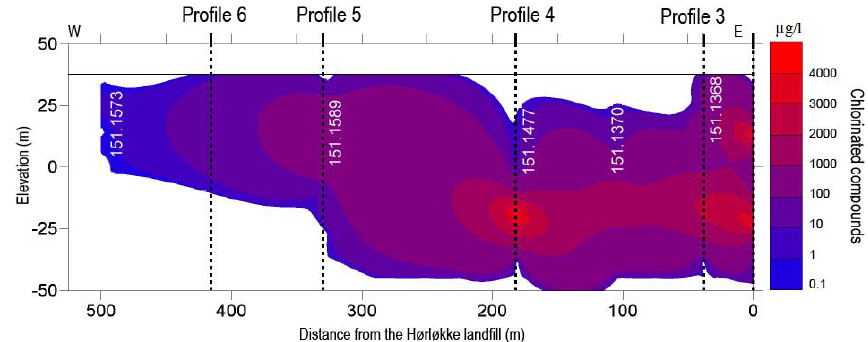
Fig. 2. Cross-section of the contaminated plume. Concentration levels refer to the total sum of chlorinated compounds. Dashed lines show the locations where the profiles cross the plume and the different numbers refer to deep boreholes (Fig. 1). Modified from Pedersen